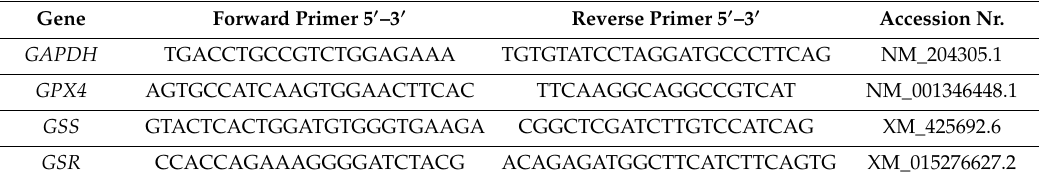
Table 2. The used real-time PCR primers of target and endogenous control genes.